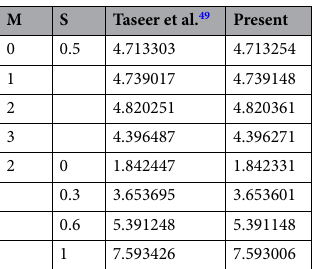
Table 2. Comparison of numerical results of F ″ (1)